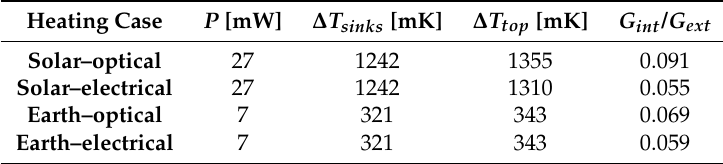
Table 5. Thermal simulation results for the different heating